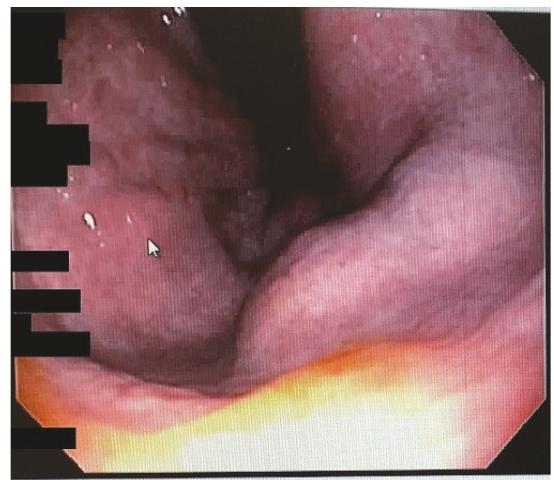
Figure 1: Endoscopic view approximately 6-7cm from the anal verge showing a 15mm bulging subepithelial